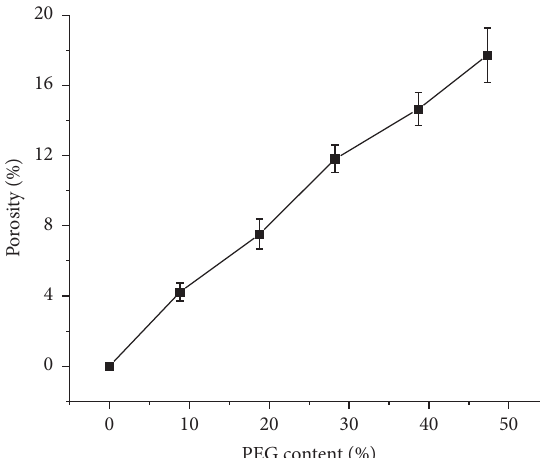
Figure 2: Porosity of modified fibers obtained from different PEG contents.